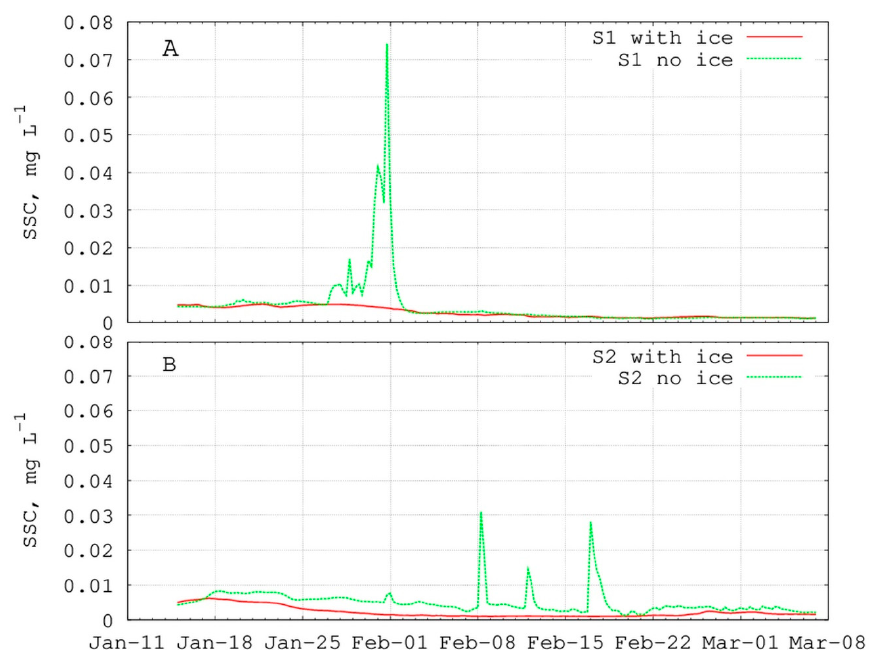
Figure 11. Simulated suspended sediment concentration with and without ice cover at monitoring station S1 ( A ) and S2 ( B ) during the first part of 2014.